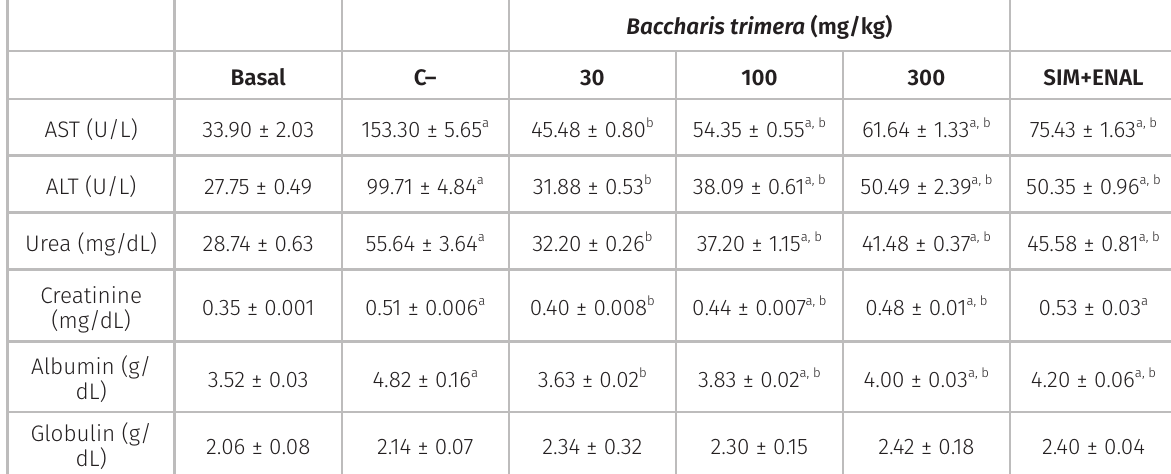
Table I. Plasma biochemical profile in hypertensive, dyslipidemic, and smoker Wistar rats that were treated with vehicle, Baccharis trimera , and simvastatin +